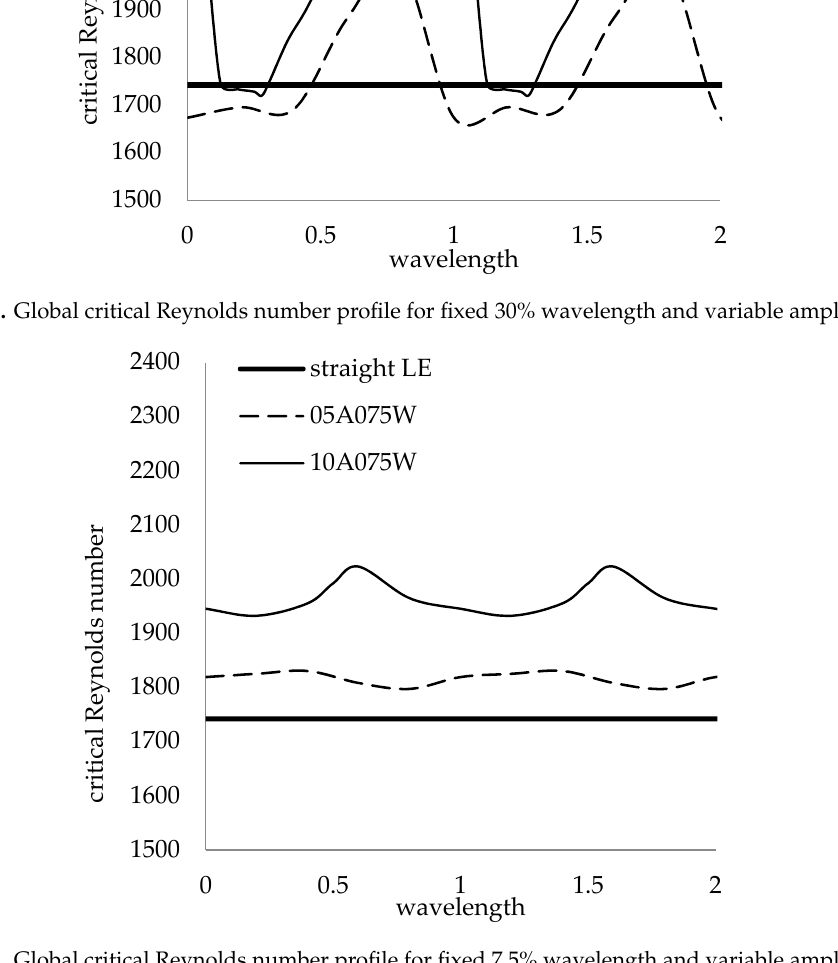
Figure 24. Global critical Reynolds number profile for fixed 7.5% wavelength and variable amplitudes.